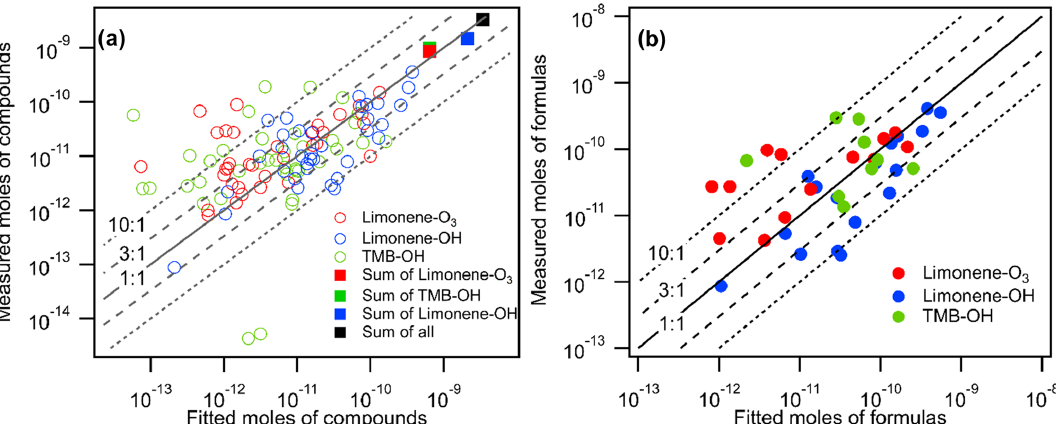
Figure 6. Measured moles of (a) compounds and (b) formulas (i.e., summation of isomers within each formula) in all oxidation experiments vs. their fitted moles using the linear regression equation obtained in Fig.